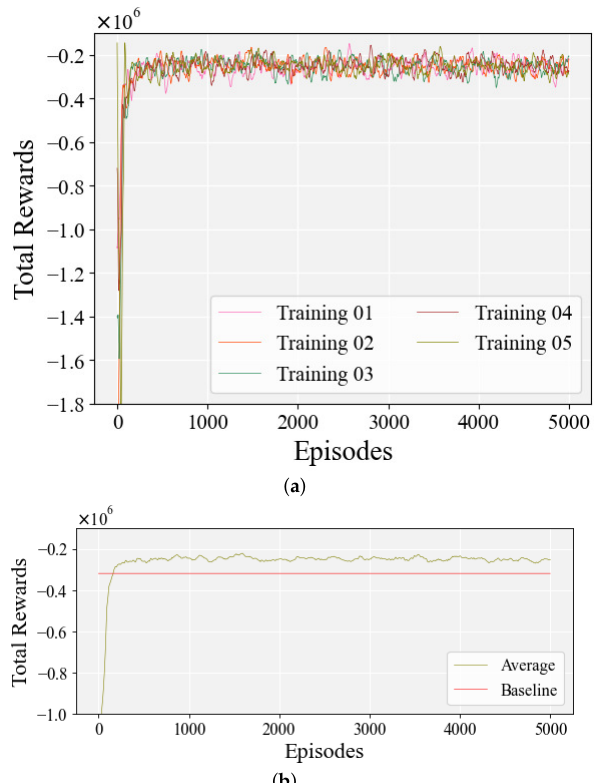
Figure 13. The learning process of KA-DDPG with criteria action and guiding reward methods: ( a ) total rewards for each learning process and ( b ) the average value of the total